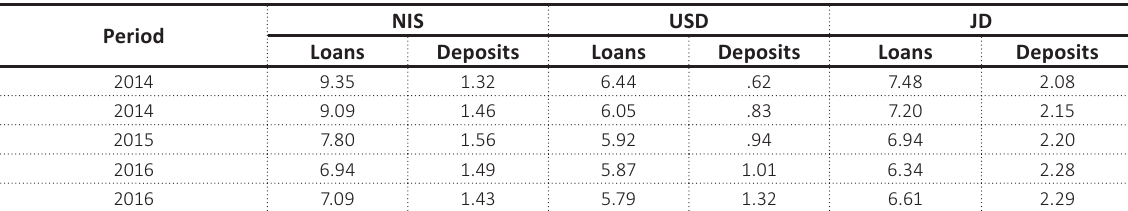
Table 5. Comparison of Palestinian national budget